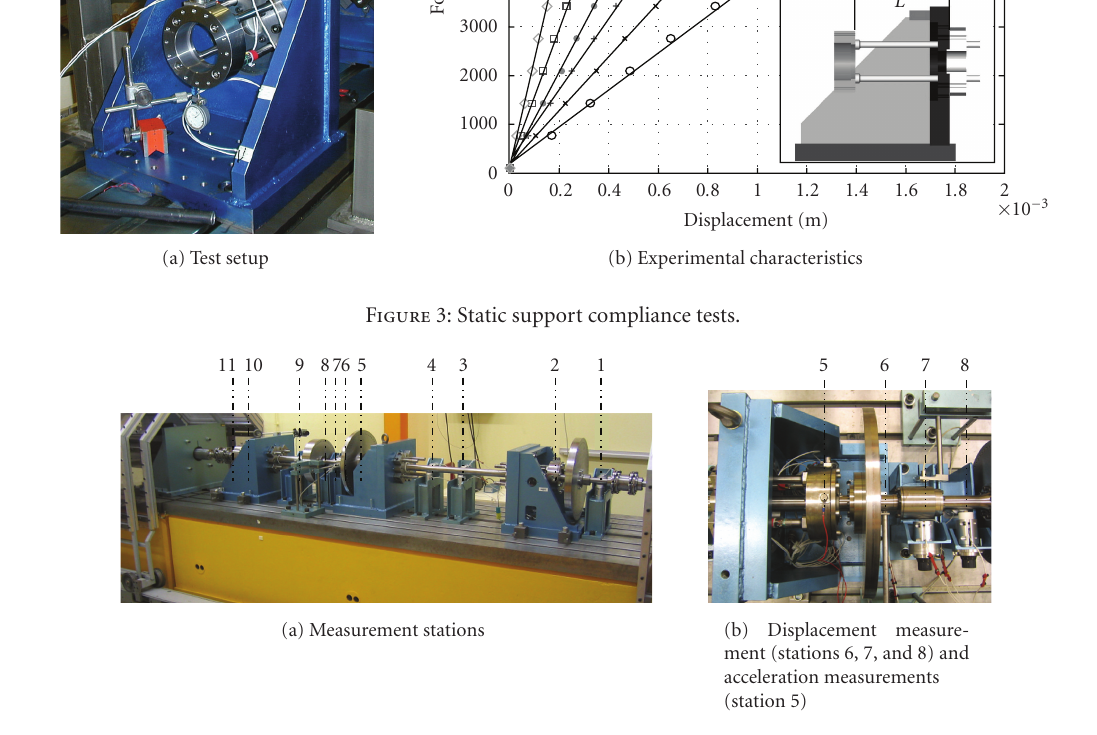
Figure 4: Measurement instrumentation of the dual-shaft test